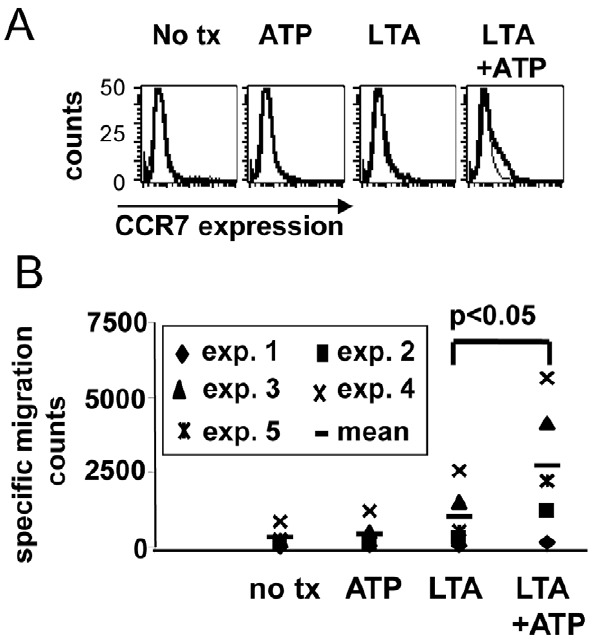
Figure 3. LTA and ATP synergistically promote migration toward CCR7 ligands. (A) FACS analysis of activated monocytes stained with FITC-anti CCR7 antibody. Results shown from one of 4 representative experiments with different donors. (B) Harvested cells were placed in the top chambers of transmigration cluster plates suspended over a lower chamber containing SFM supplemented with 250 ng/ml each CCL19 and CCL21. After 1.5 h all cells from lower chambers were harvested in equal volumes and counted for 60 seconds using flow cytometry. Results shown include 5 separate experiments with different donors.